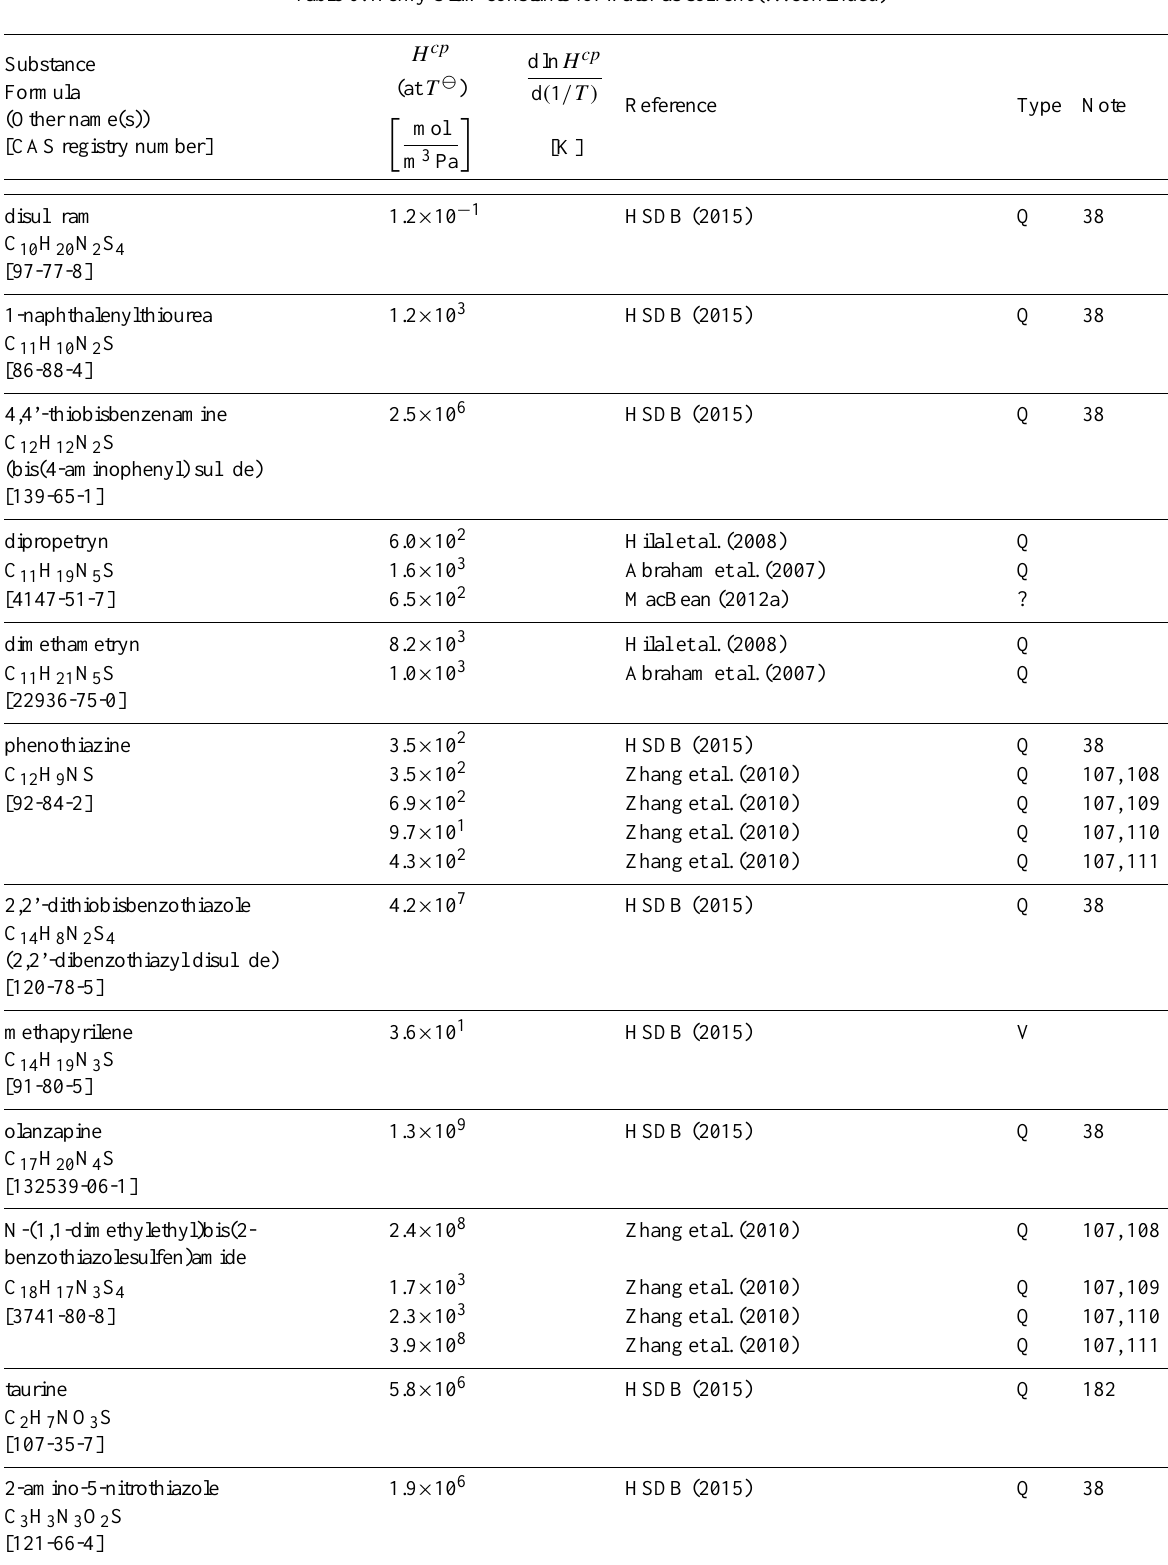
Table 6: Henry’s law constants for water as solvent